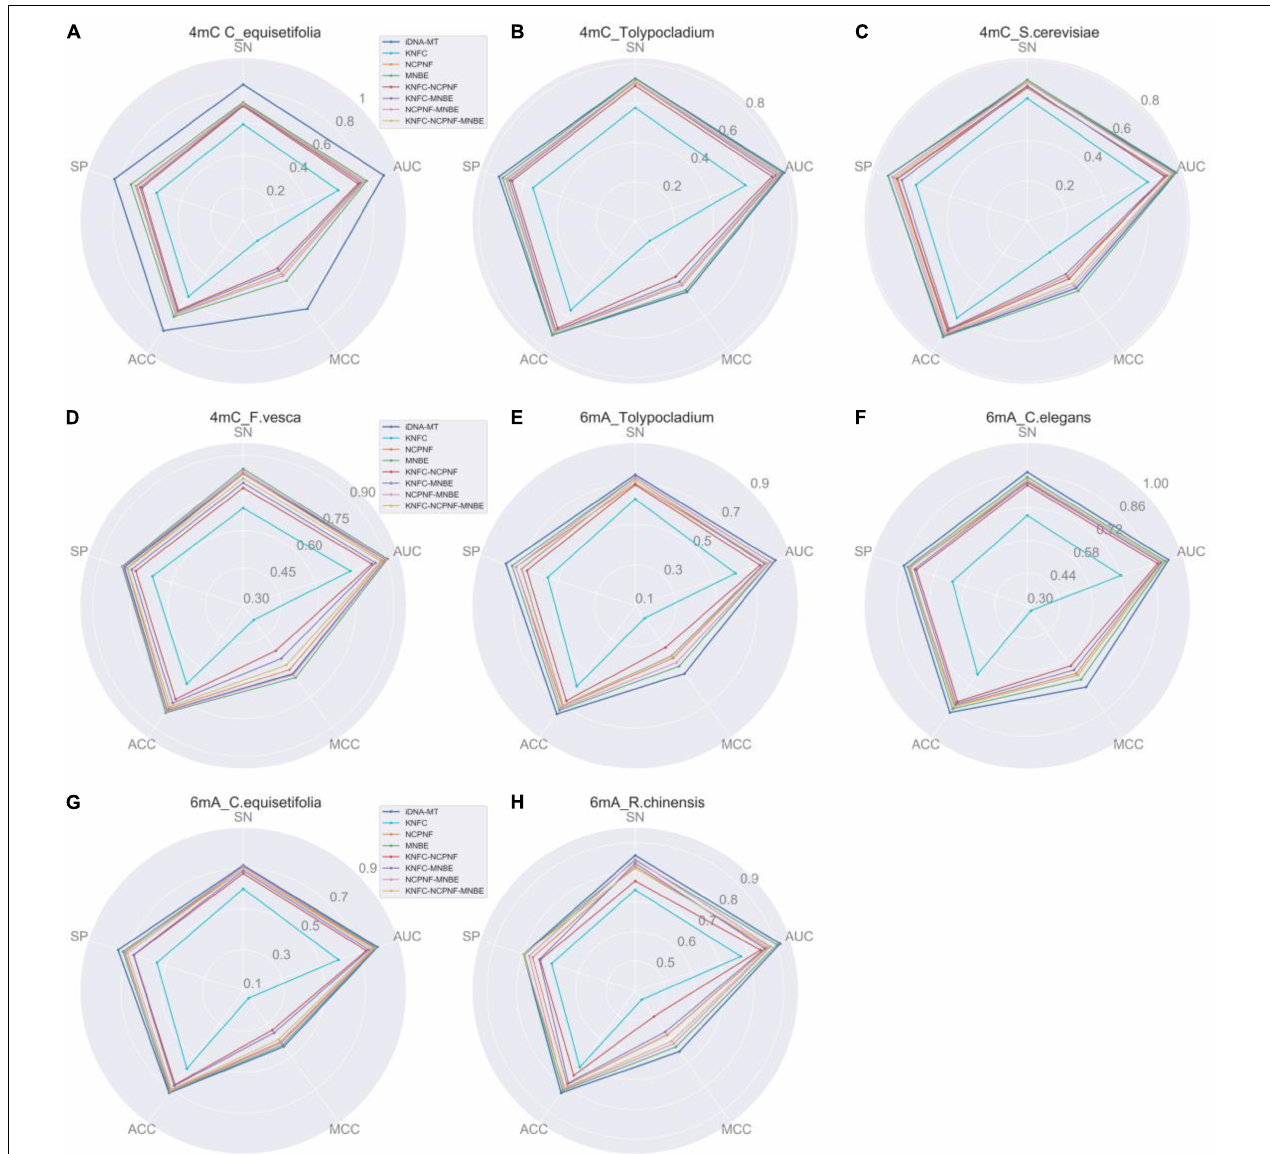
FIGURE 3 | Performance evaluation of iDNA-MT and seven state-of-the-art methods for identifying 4mC site and 6mA site. (A–D) represents the performance of identifying 4mC site. (E,F) represents the performance of identifying 6mA site. (A–D) represent the performance of different methods for identifying 4mC site. (E–H) represent the performance of different methods for identifying 6mA